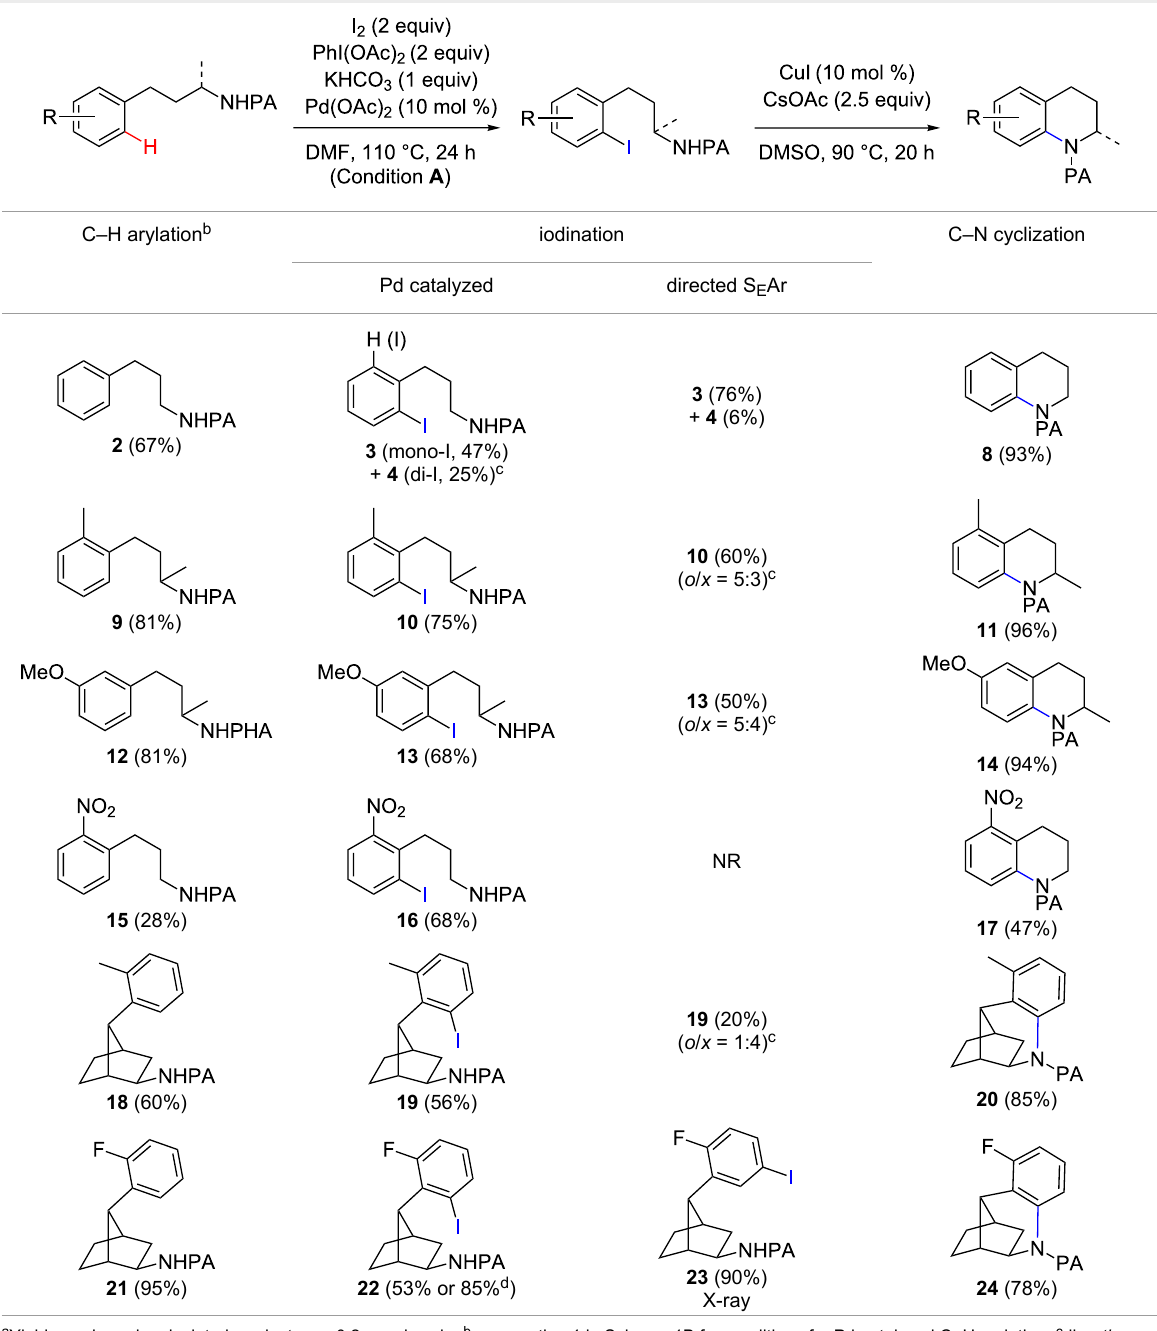
Table 2: Substrate scope of Pd-catalyzed ε -C − H iodination and Cu-catalyzed C − N cyclization to form THQs a